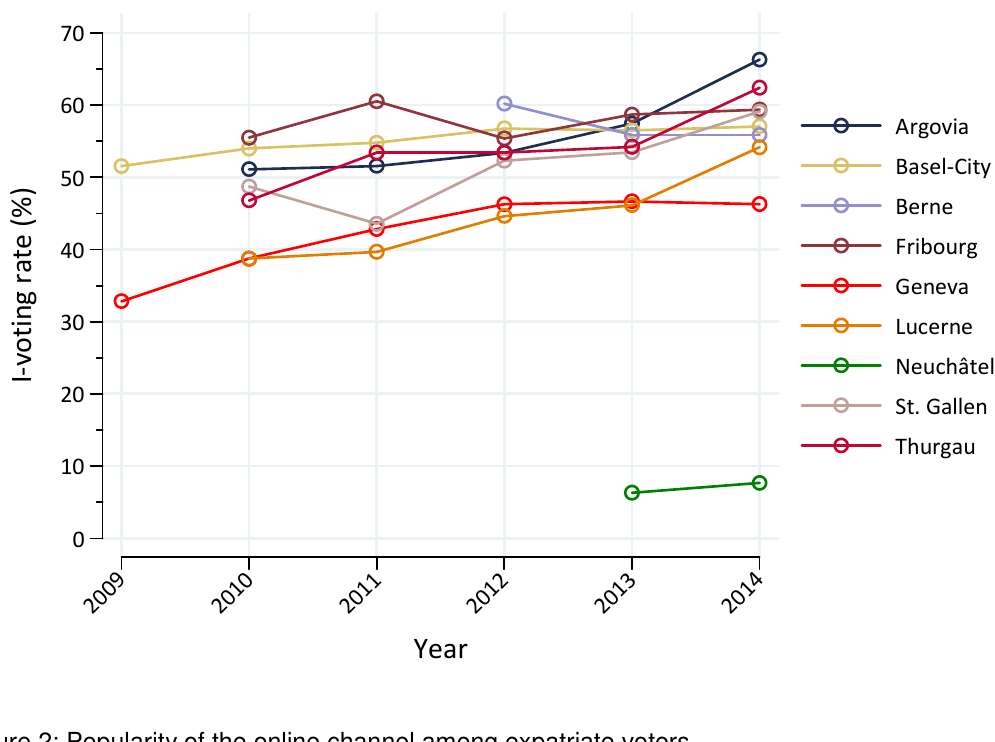
Figure 2: Popularity of the online channel among expatriate voters